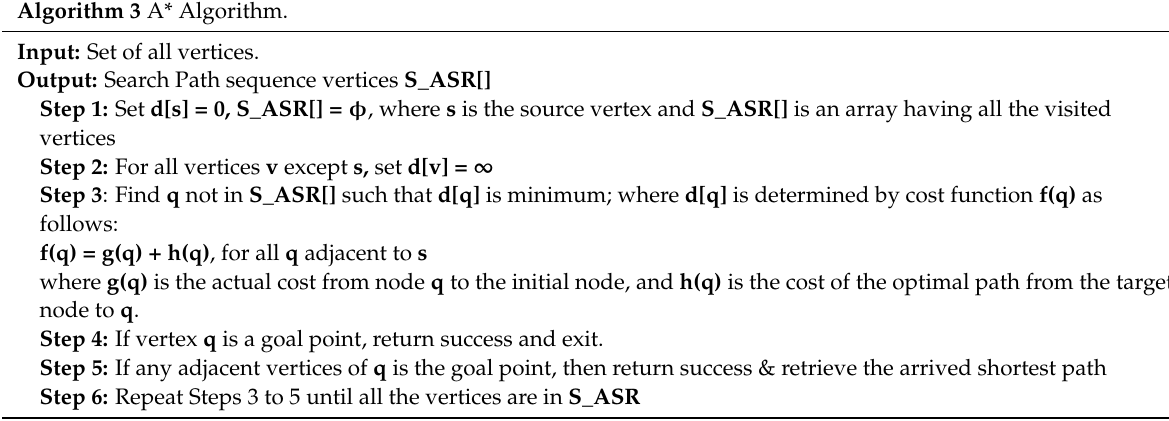
Algorithm 3 A* Algorithm.